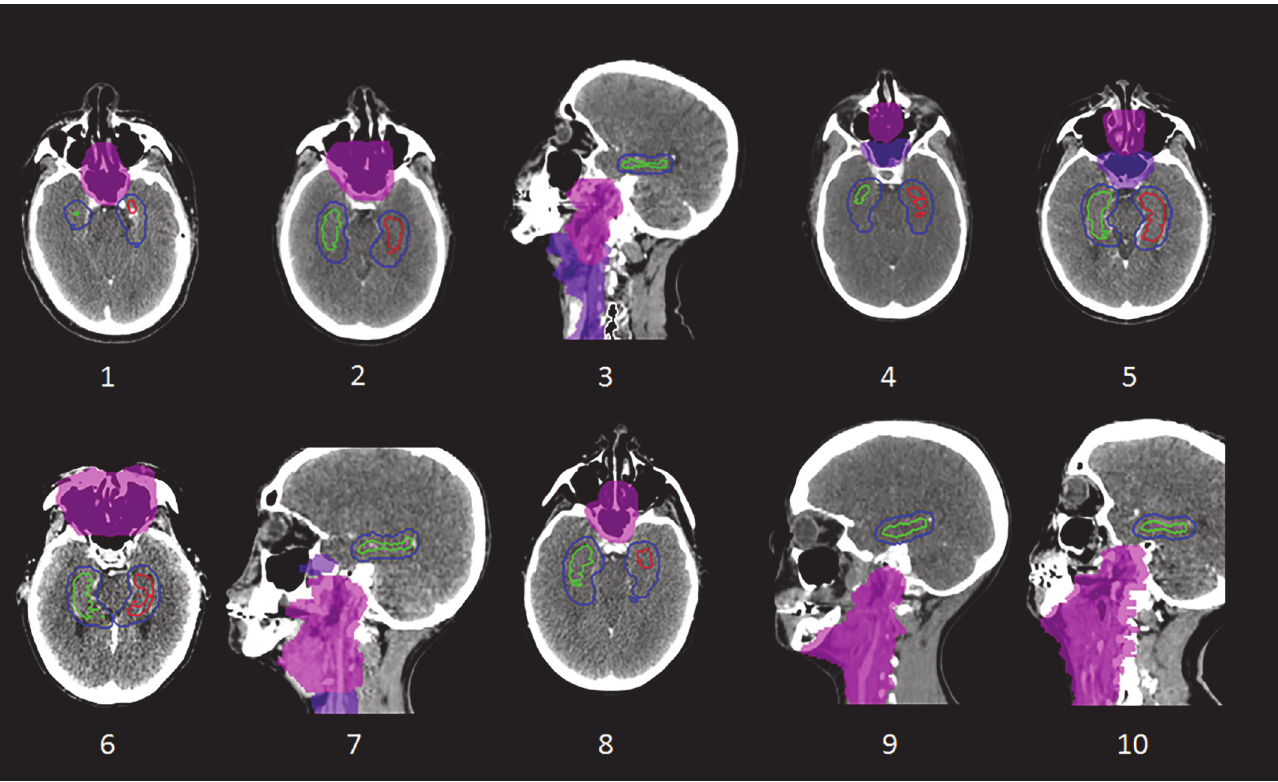
Fig 2. Disposition of PTVs and hippocampal PRVs for the 10 cases. Case numbering is as per Table 1. PTV1 is shown as a light pink colourwash, PTV2 as a purple colourwash, while the left hippocampus, right hippocampus and hippocampal PRVs are illustrated as red, green, and blue contours respectively. Axial or sagittal views are shown for each case according to the plane that transects both